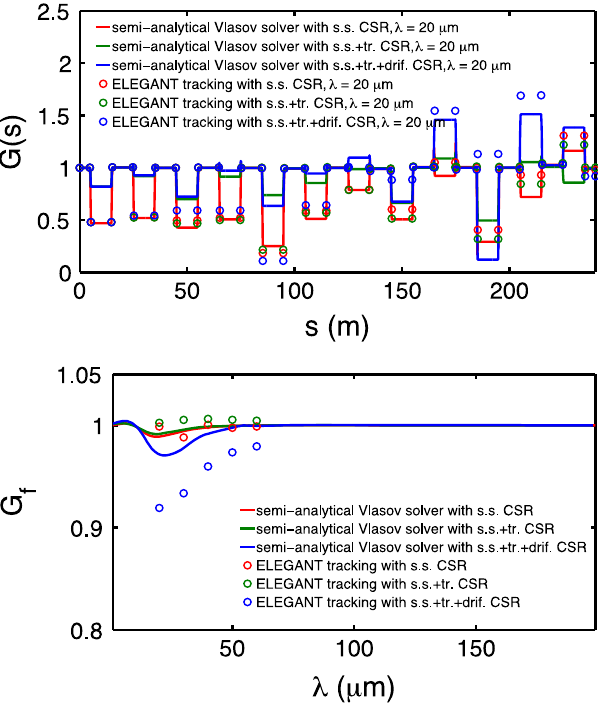
FIG. 3. (Top) CSR gain functions G ð s Þ ; (bottom) gain spectra λ Þ as a function of initial modulation wavelength. Initial G f ð density modulations are all set 0.8% in ELEGANT tracking simulations. The apparent difference between Vlasov solutions and ELEGANT tracking is actually small; note the vertical scale in small